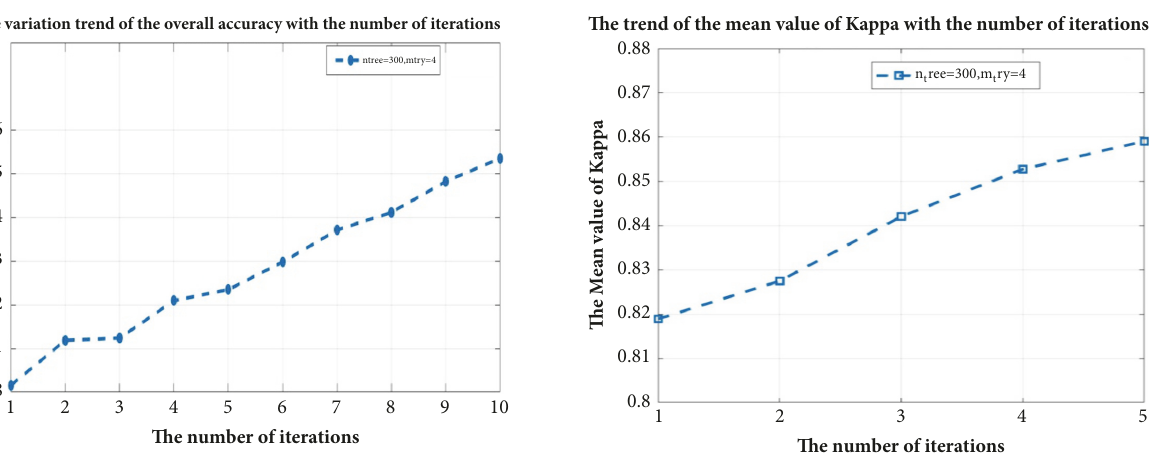
Figure28:Classificationkappatrendofdifferentinitialanditerative condition of AVIRIS data for method 2.